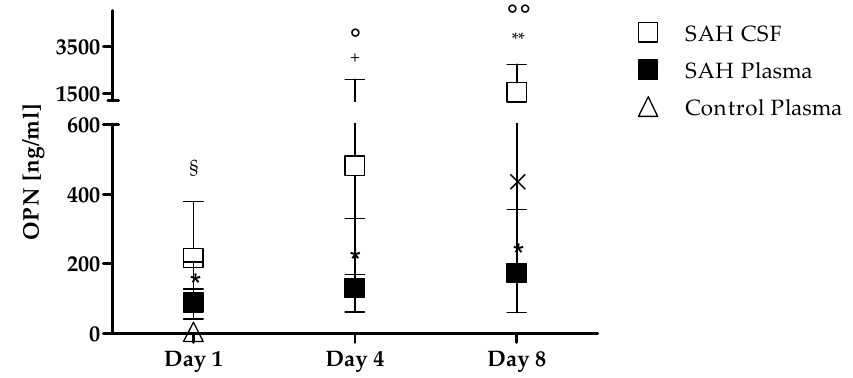
Figure 1. OPN levels in CSF (open square), plasma (solid square) of SAH patients and in plasma of healthy controls (open triangle). Samples from SAH plasma patients at day 1, day 4, and day 8 are significantly higher than plasma levels in healthy controls. Data are expressed as median and interquartile range. * p < 0.0001 vs. control plasma, Mann–Whitney test. Samples in CSF and plasma were compared at each time point with Wilcoxon matched-pairs signed rank test. § p = 0.0016; + p = 0.0005; ** p = 0.0002. Plasma OPN levels were compared at day 1 vs. day 4, and at day 8 vs. day 4 with Wilcoxon matched-pairs signed rank test. A similar analysis was performed for CSF samples. In plasma × p = 0.046 day 8 vs. day 4; in CSF ° p = 0.001 day 4 vs. day 1, °° p = 0.034 day 8 vs. day 4.